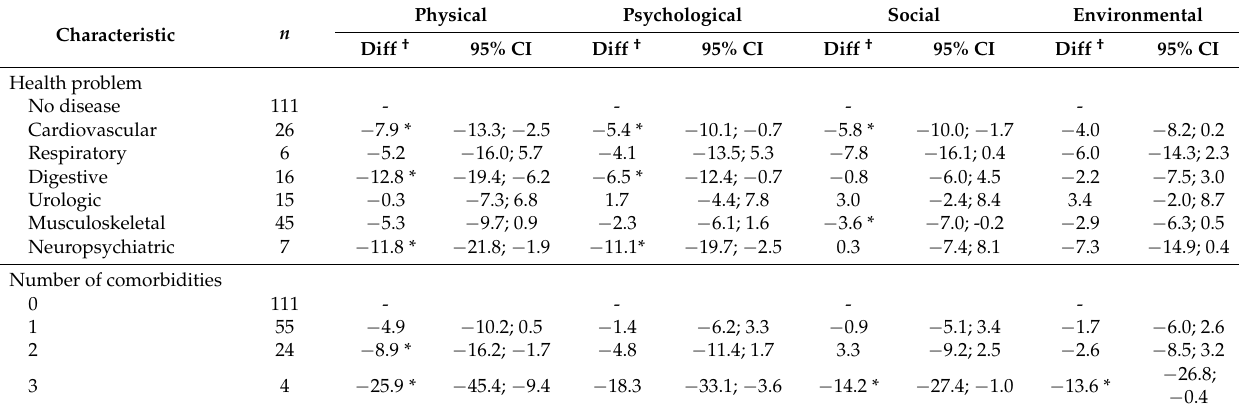
Table 4. Between-group minimal clinically important difference (MCID) of WHOQOL-BREF domains scores for different comorbidities.